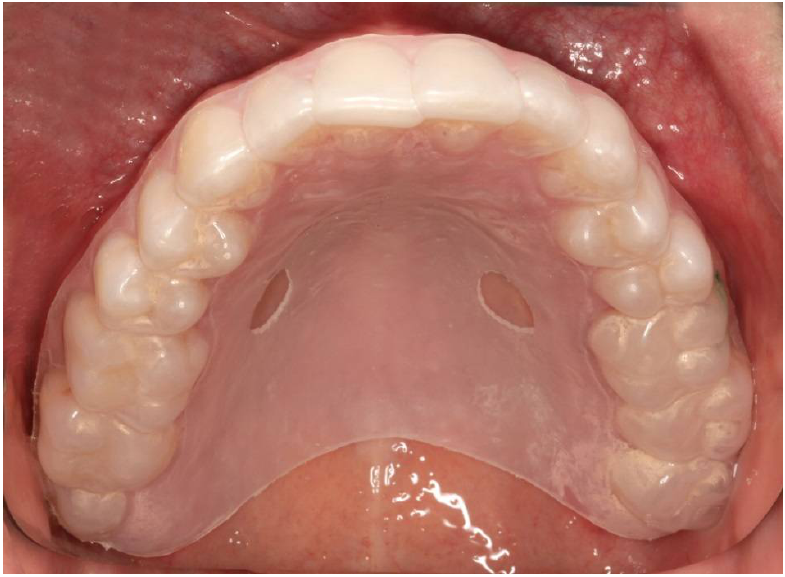
Figure 2. Individual splint for mucosal smear.